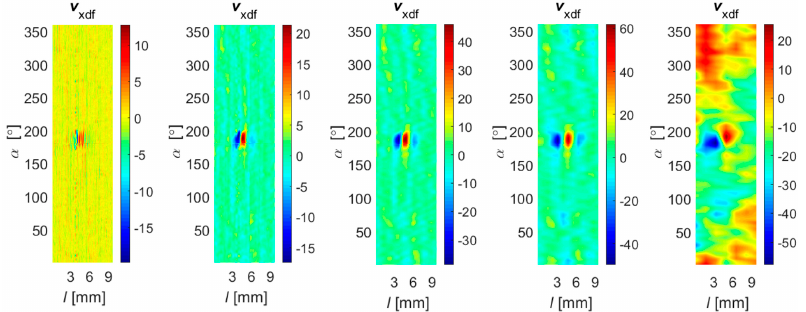
Figure 13. A visualization of exemplary results of successive levels of Laplacian pyramid decomposition obtained for v x of a selected sensor.